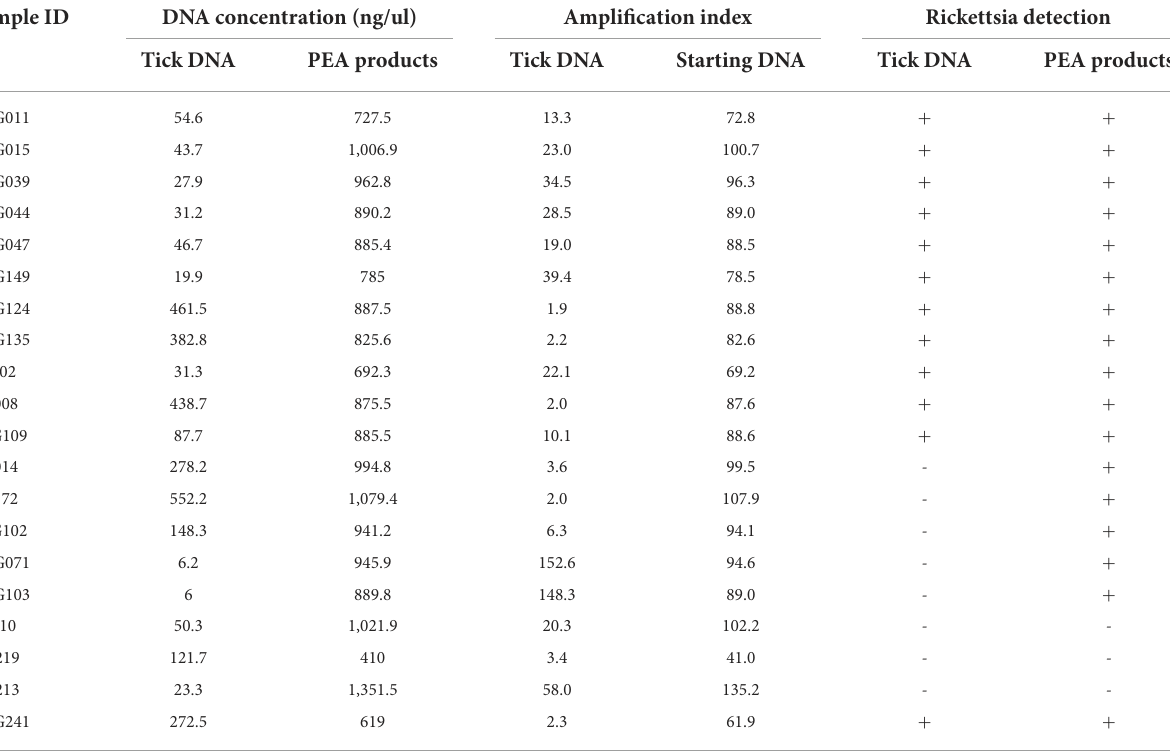
TABLE 1 Concentrations of PEA amplification of tick DNA and Rickettsia detecting proportion.